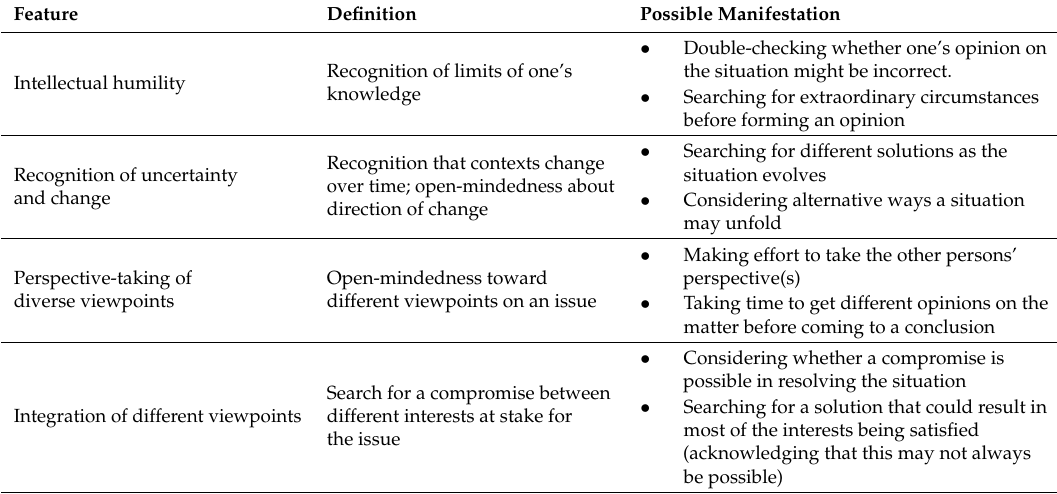
Table 1. Features, definition, and possible manifestations of wise reasoning in everyday life, represented by frequently co-occurring aspects of